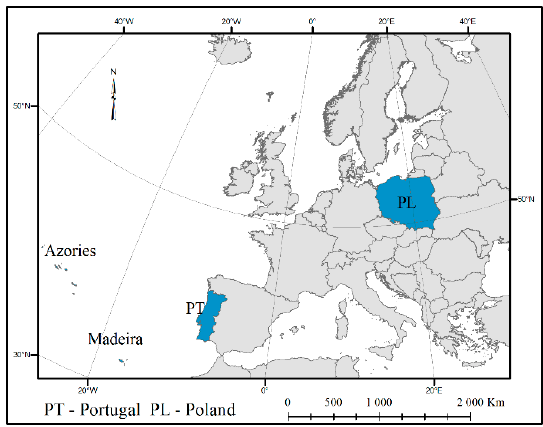
Figure 1. Location of Poland and Portugal in Europe.